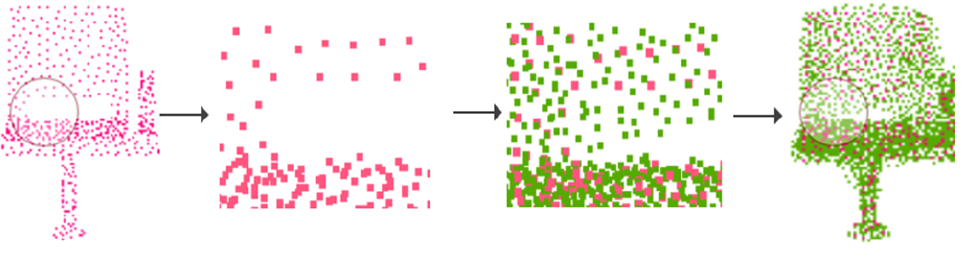
Figure 1. The holes in the chair are overfilled. The red point cloud represents the original point cloud, and the green point cloud represents the point cloud after upsampling. In order to compare the upsampling effect clearly, we use a circle to select the hole part of the chair for